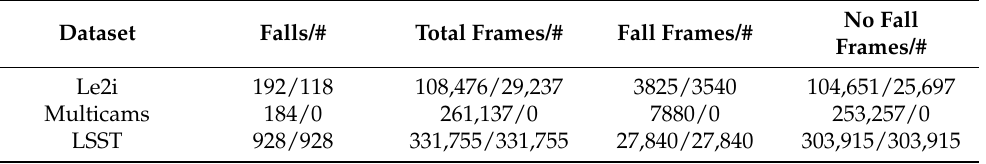
Table 2. The statistics of Le2i, Multicams, and large-scale spatio-temporal (LSST) dataset: number of falls, total frames, number of fall frames, and number of no fall frames. The notation # means that only the video-annotated bounding boxes are